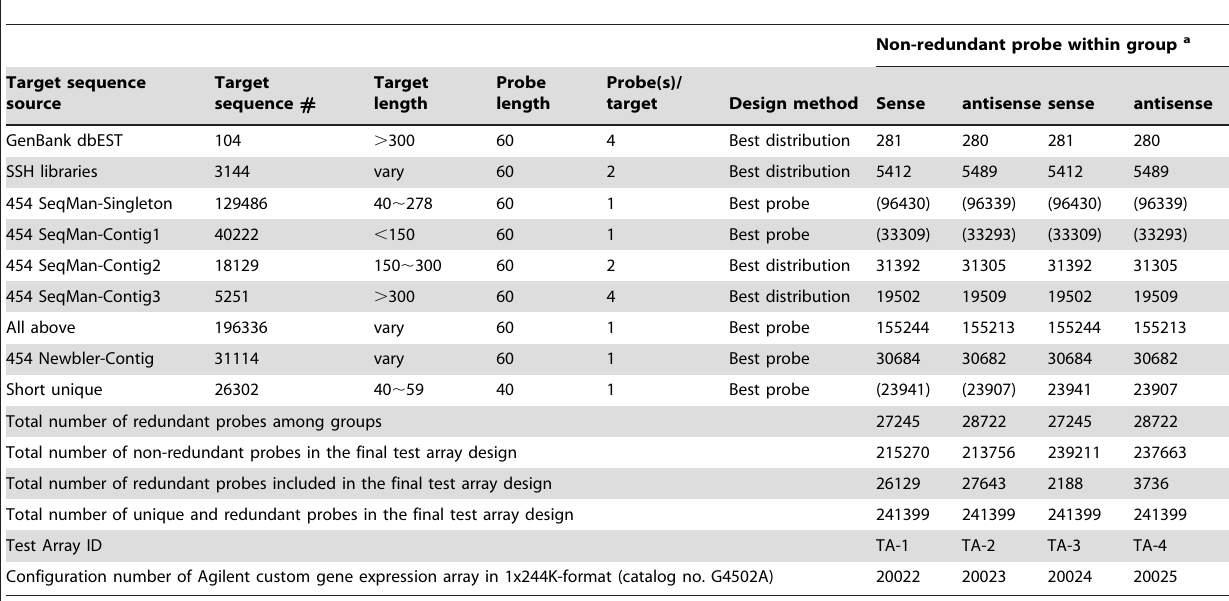
Table 3. Design of four 244K-oligo probe test arrays using Agilent’s eArray.